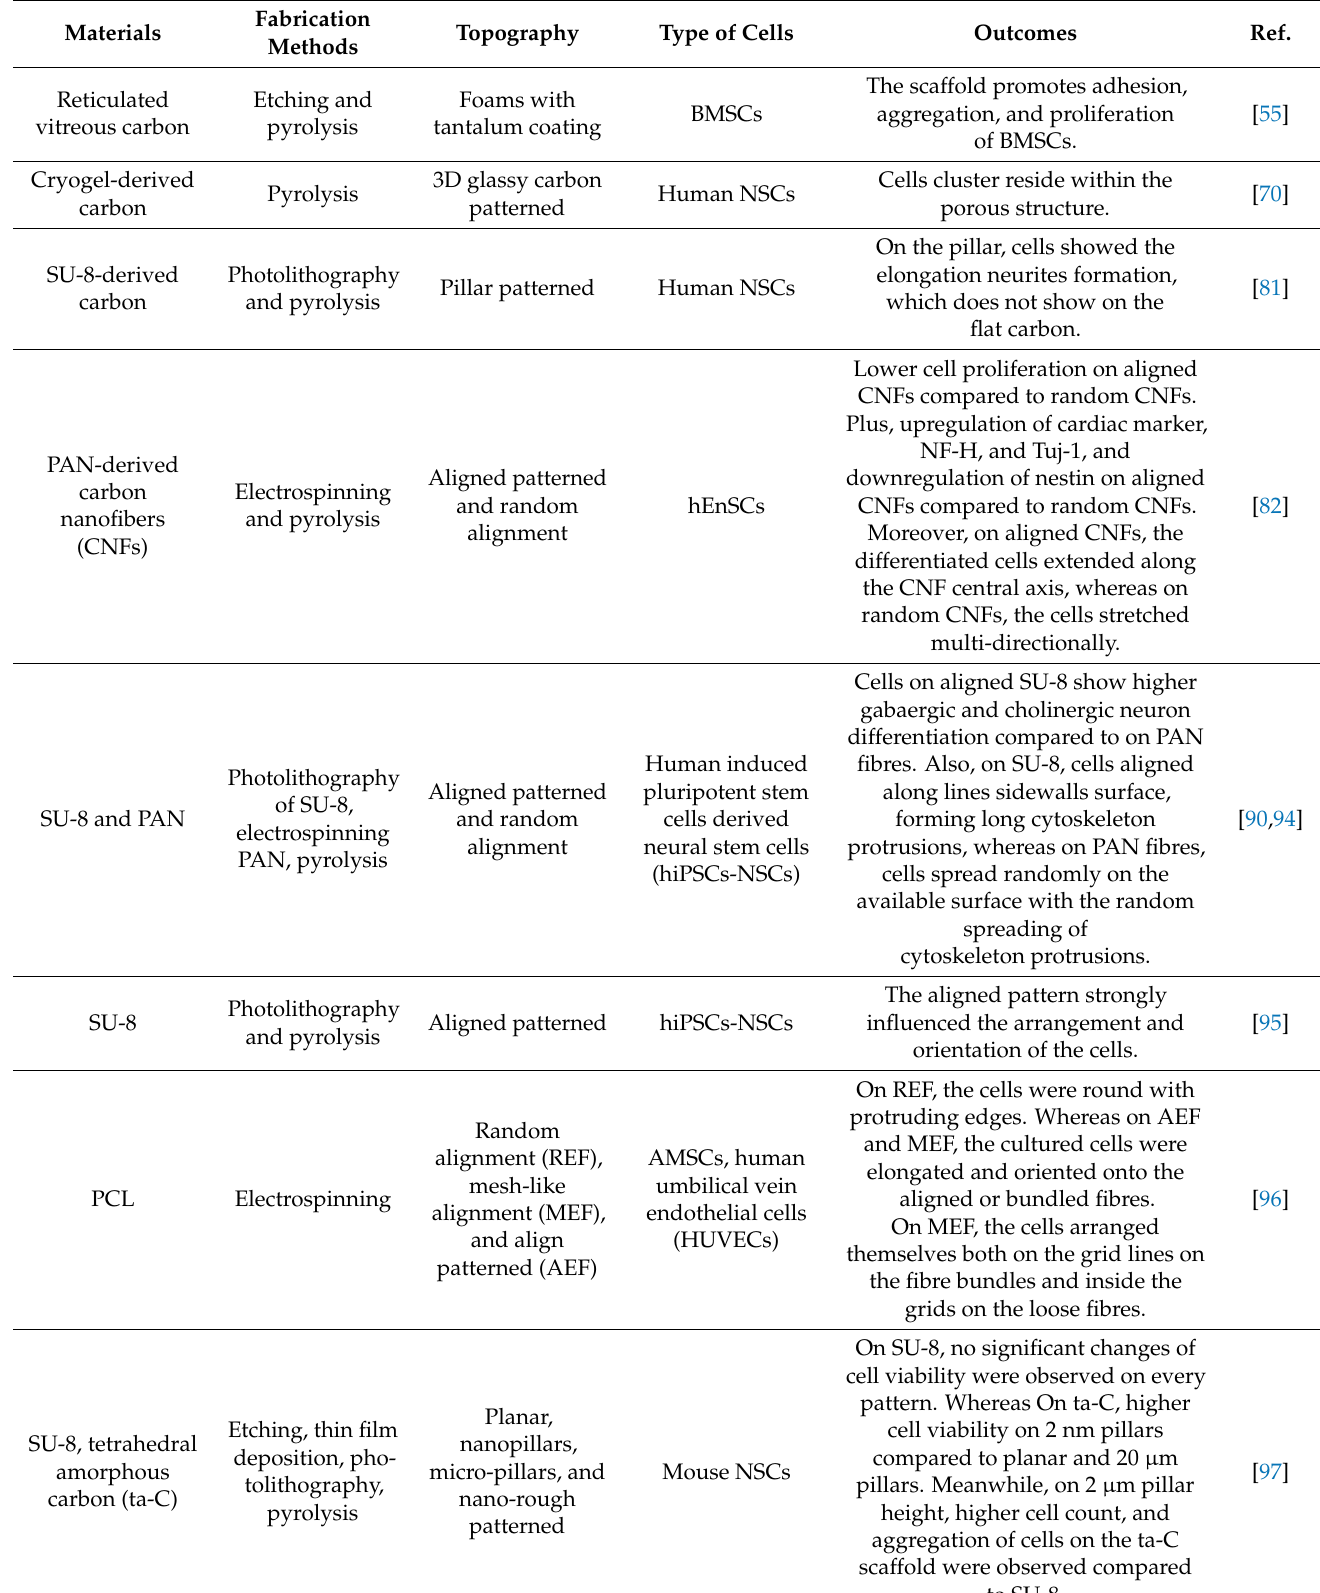
Table 3. Topographies influence the behaviour of SCs on a